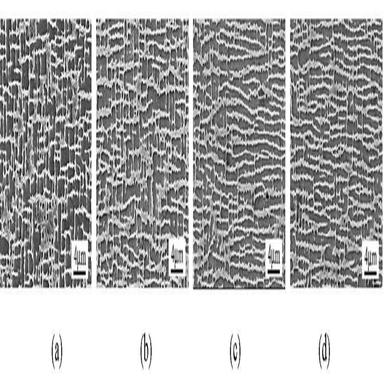
Microstructures of Arc-section specimen after creep at 1100 ◦C and various stresses for 100 h. (a) 40 MPa, (b) 70 MPa, (c) 90 MPa, (d) 110 MPa.